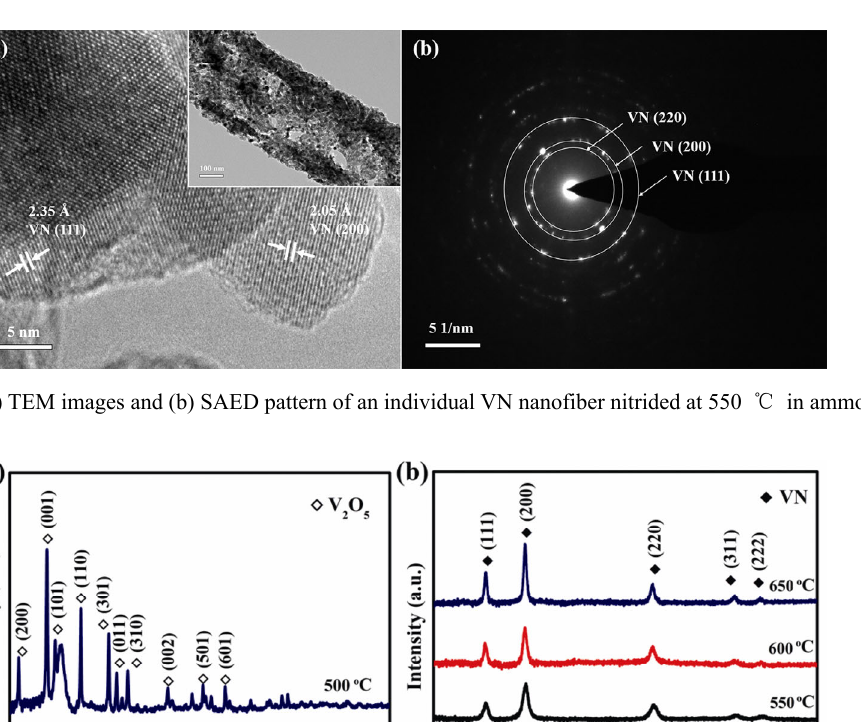
Fig. 2 (a) SEM images of V 2 O 5 nanofibers, and SEM images of VN nanofibers nitrided at (b) 550, (c) 600, and (d) 650 ℃ . Insets: the corresponding high resolution SEM images.